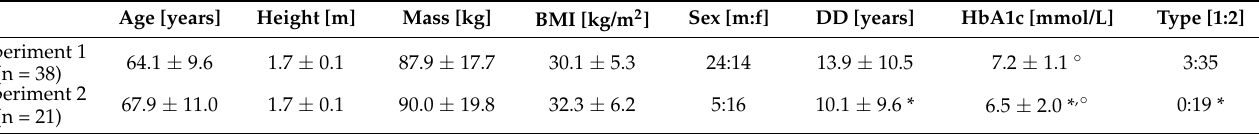
Table 1. Anthropometric and clinical characteristics of the subjects, divided according to